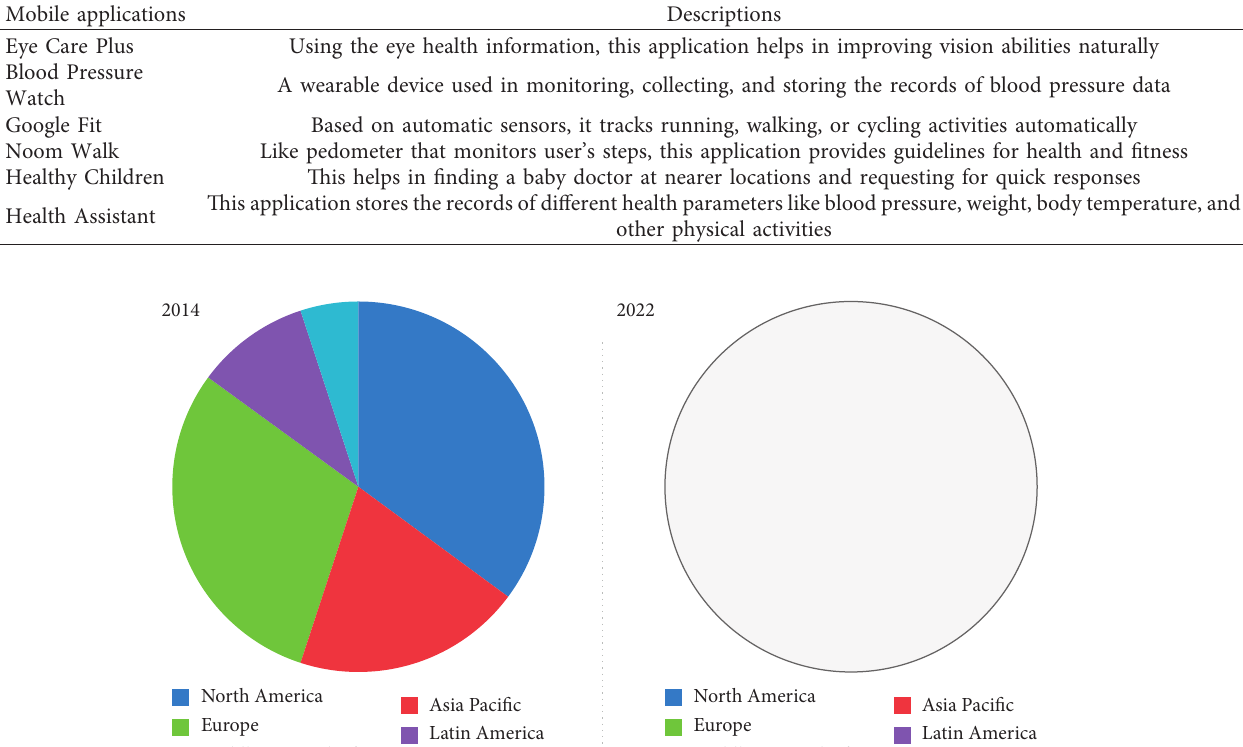
Table 1: Smart phone-based healthcare applications.